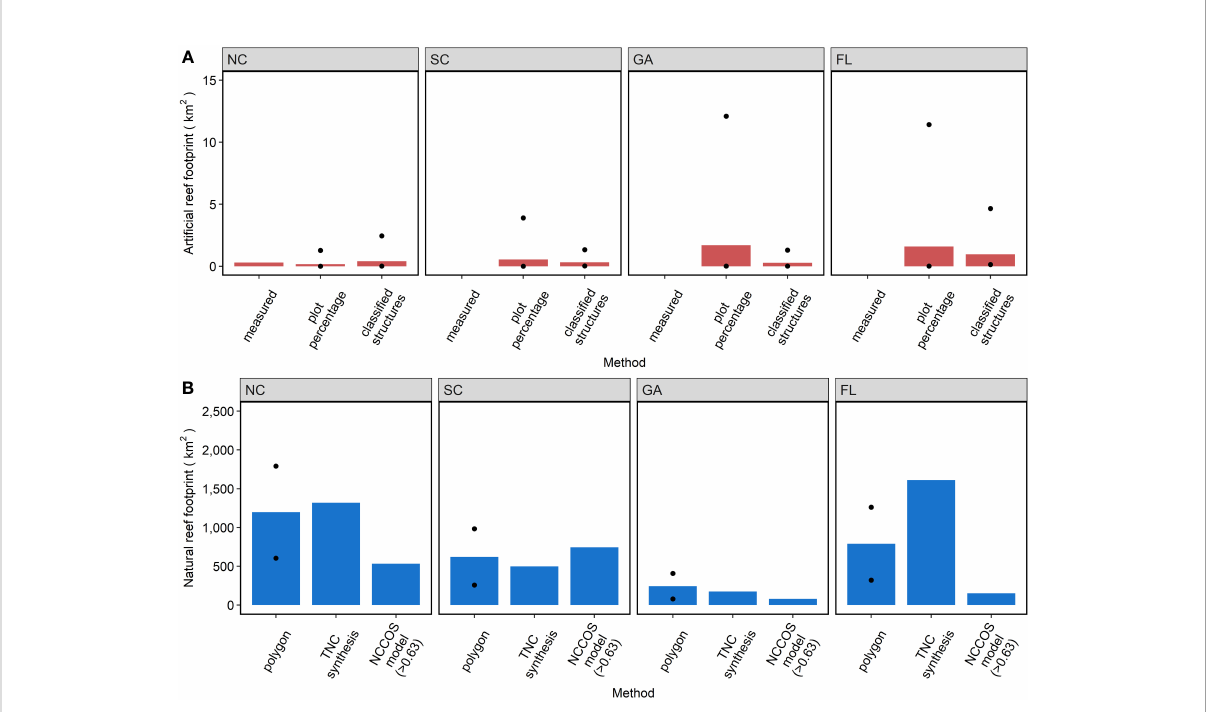
FIGURE 4 Footprint (km 2 ) of arti fi cial reefs ( A , red) and natural reefs ( B , blue) by state (columns). Measured approach for arti fi cial reef footprint was only available in NC. Black circles represent the maximum and minimum extent values for applicable methods. Note different y-axis scales between panels (A, B)